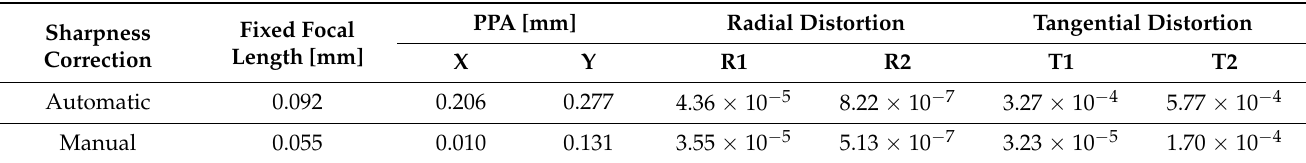
Table 6. Presentation of results for the automatic and manual methods (standard